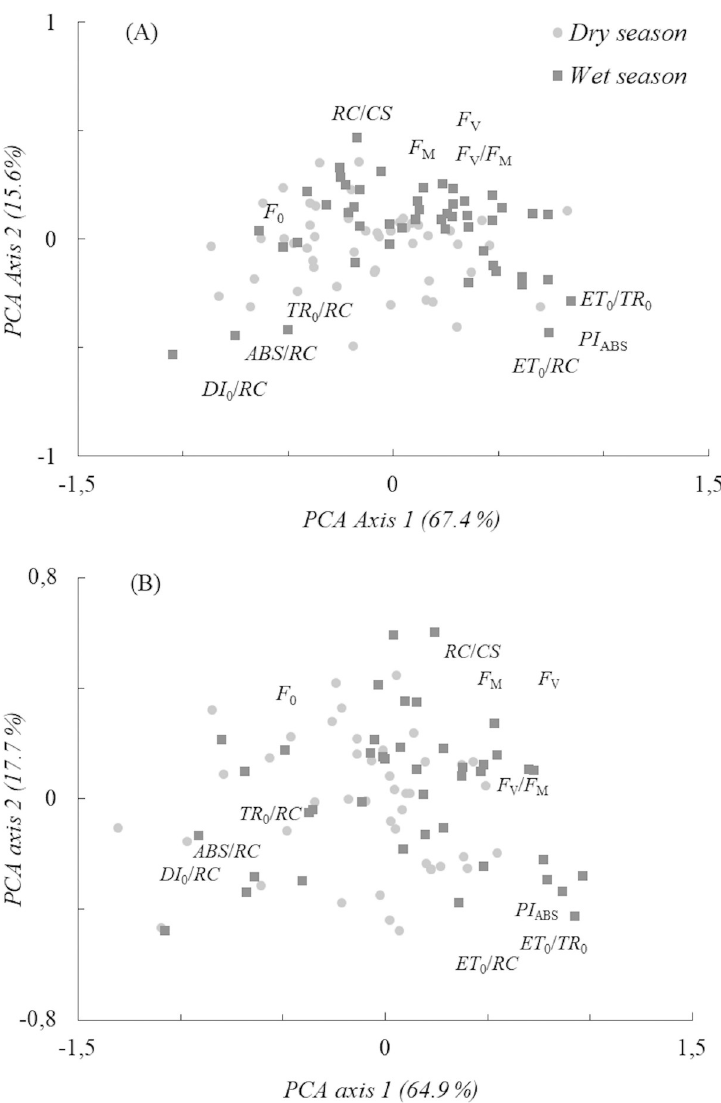
Fig 2. PCA ordination of seasonal effects in the high- (A) and low-nutrient (B) treatments. F 0 , initial, F M , maximum and F V , variable fluorescences; F V / F M , maximum quantum yield; PI ABS , performance index; ET 0 / TR 0 , efficiency of electron transport; DI 0 / RC , energy dissipation; ABS / RC , antenna size; ET 0 / RC , electron transport flux; TR 0 / RC , maximum trapped exciton flux; RC / CS , density of reaction centers per cross-section. ChF variables are approximately placed according to the product-moment (correlation loading) values along both PCA